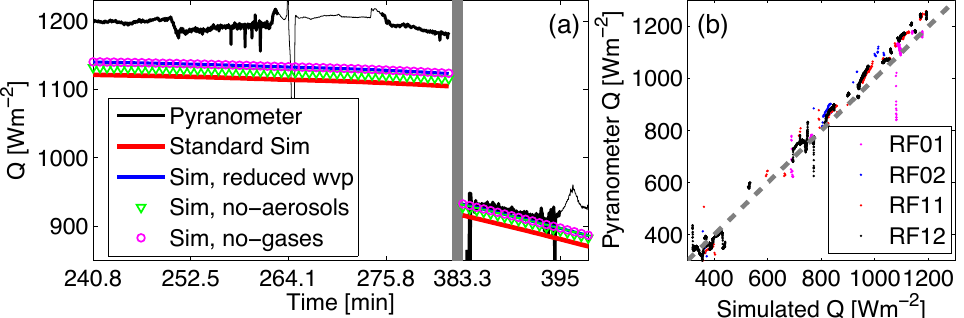
Figure 3: Simulated and pyranometer irradiances: (a) Time series during RF12. The pyranometer irradiance is denoted by the black line, and the thick black line represents periods with clear-sky conditions. The red line is the standard simulation, whereas the blue line, green triangles, and magenta circles represent the simulations with 50% reduction in water vapor, pristine conditions, and negligible absorbing gases respectively. (b) Scatterplot between the pyranometer irradiance and the simulated one for above-clouds